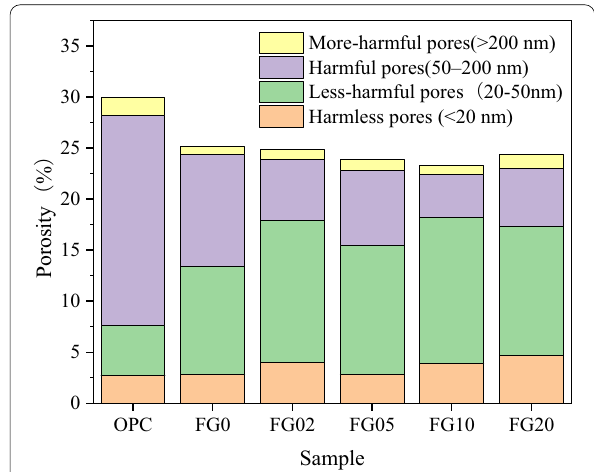
Fig. 3 Pore size distribution of 3DG-fly ash cement paste of 28 days.